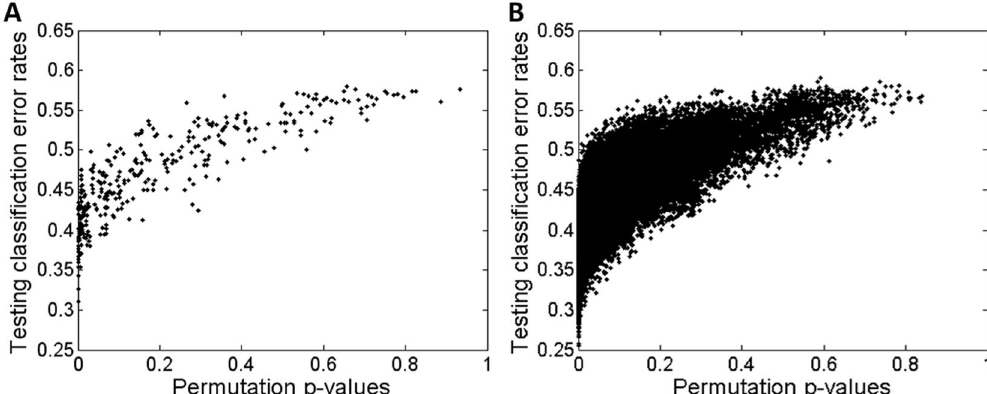
Figure 2. Necessity and feasibility of evaluating the performances of model-based perspective and boundary- based perspective. A 2D scattering plot denotes all the points with x-axis for p-values from permutations of the class label based on Welch’s t-test and y-axis for averages of classification error rates. Panel (A and B) correspond to the joint performances of each individual and pair of probes,